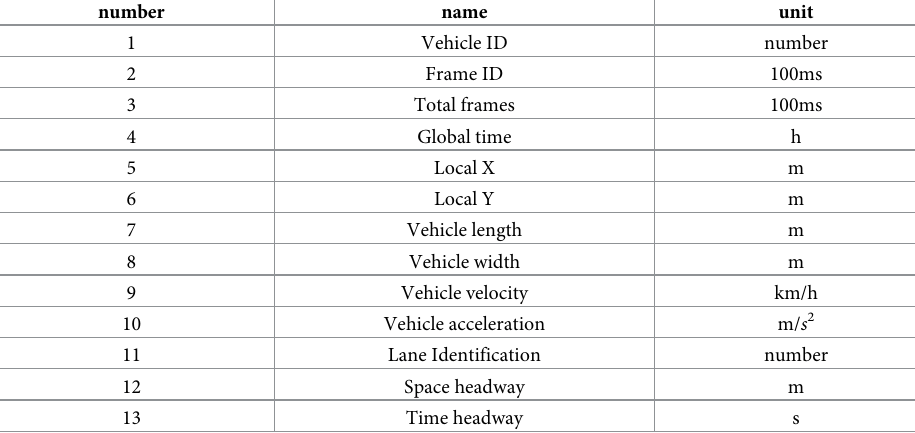
Table 1. Basic information of NIGSIM